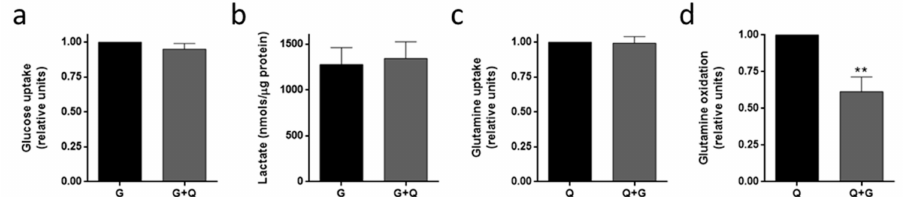
Figure 7. Substrate uptake and utilization in HUVEC. ( a ) Glucose uptake, ( b ) lactate production, ( c ) glutamine uptake and ( d ) glutamine oxidation were determined in HUVEC in the presence or absence of 5 mM glucose (G) and / or 0.5 mM glutamine (Q). Data are expressed as means ± SD of three independent experiments. ** p < 0.01 versus glutamine condition.